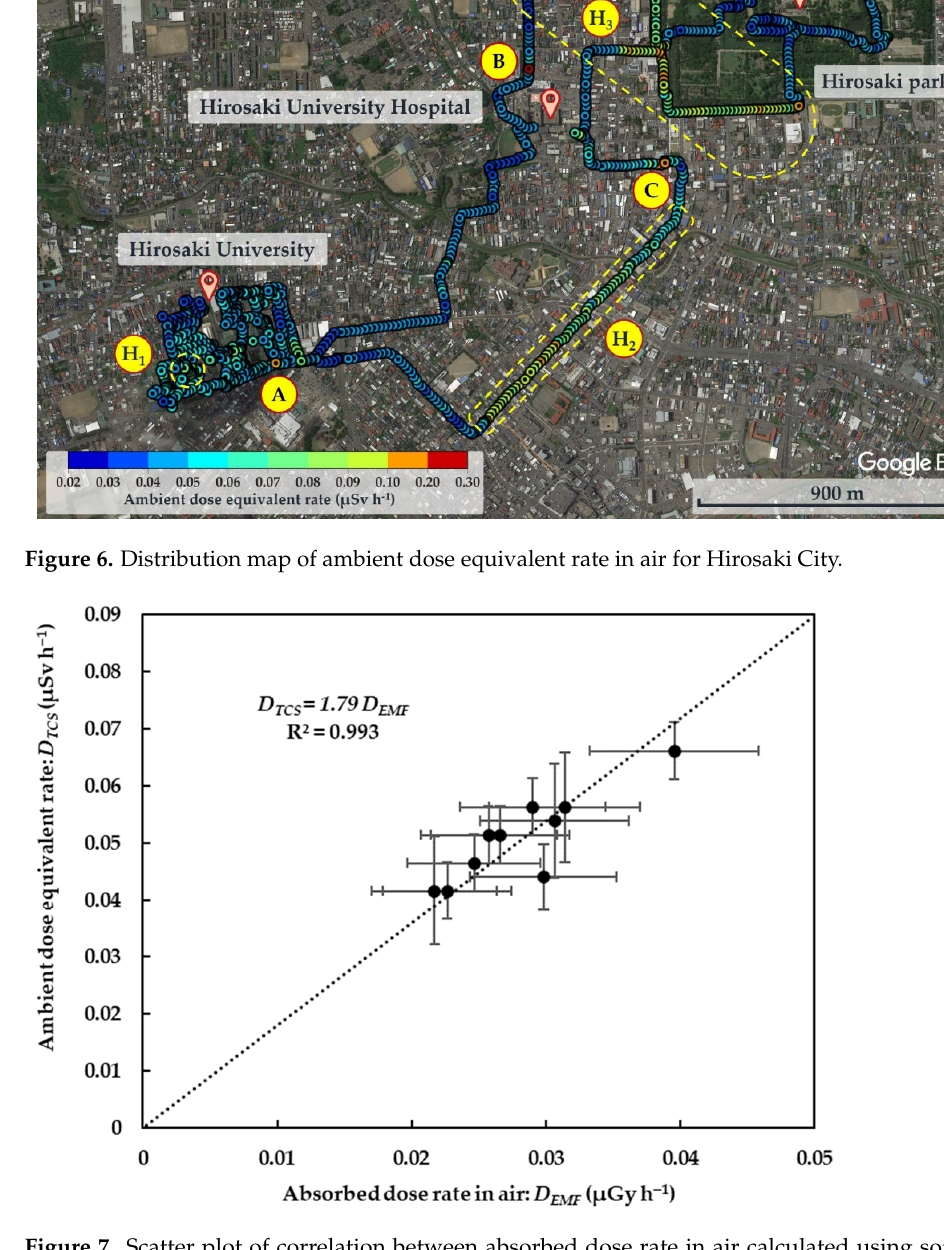
Figure 7. Scatter plot of correlation between absorbed dose rate in air calculated using software and response matrix method using the spectrometer (EMF-211) and ambient dose equivalent rate obtained using the survey meter (TCS-171).